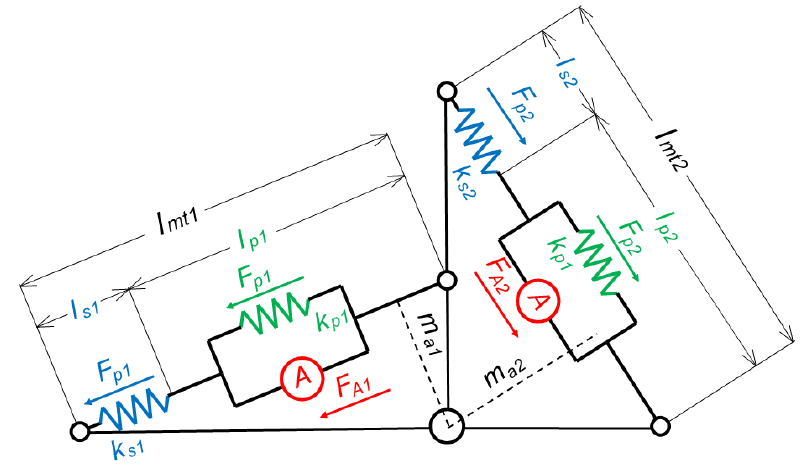
Figure 5. The forces exerted by two mono-articular muscles on a joint.